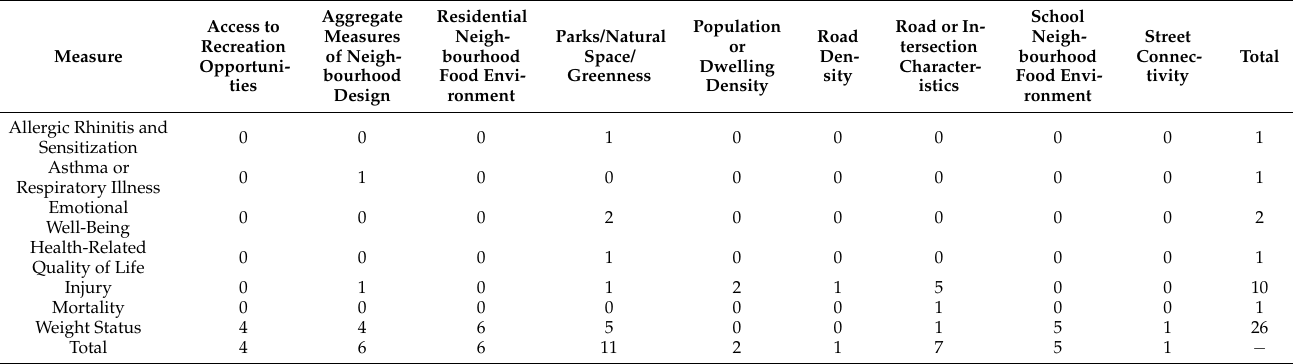
Figure 1. PRISMA-ScR flow chart of included and excluded studies. Table 1. Study count by urban form and health outcomes in Canadian studies.